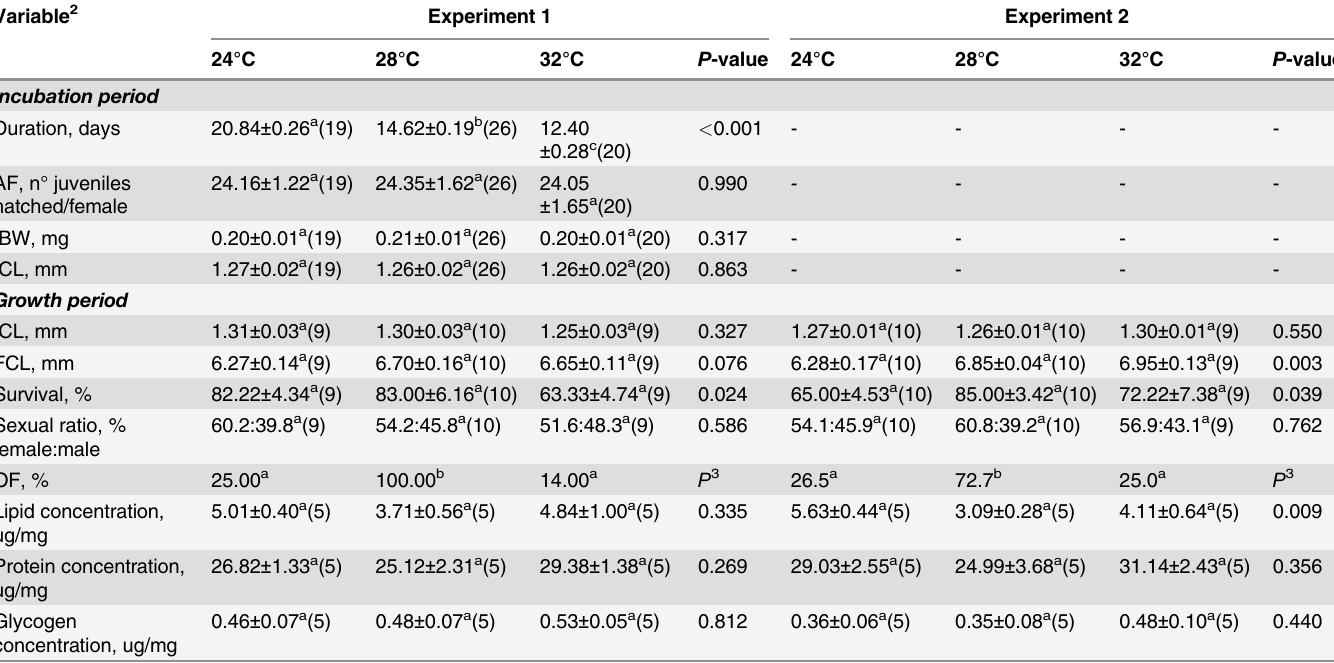
Table 1. Effect of temperature (24, 28 and 32°C) on reproduction and growth of the freshwater shrimp Neocaridina heteropoda heteropoda during the Incubation periods and Growth periods of Experiments 1 and 2. 1,2,3 Variable 2